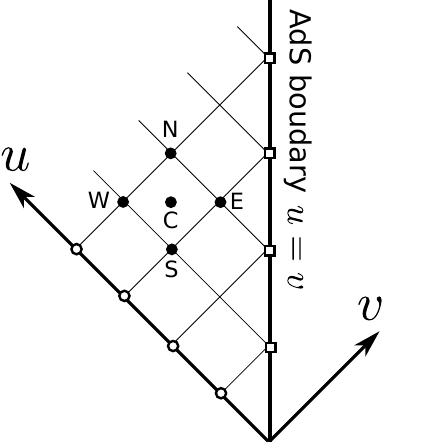
Figure 10. World volume of D7-brane. The mesh for numerical calculation is taken along double null coordinates u and v .